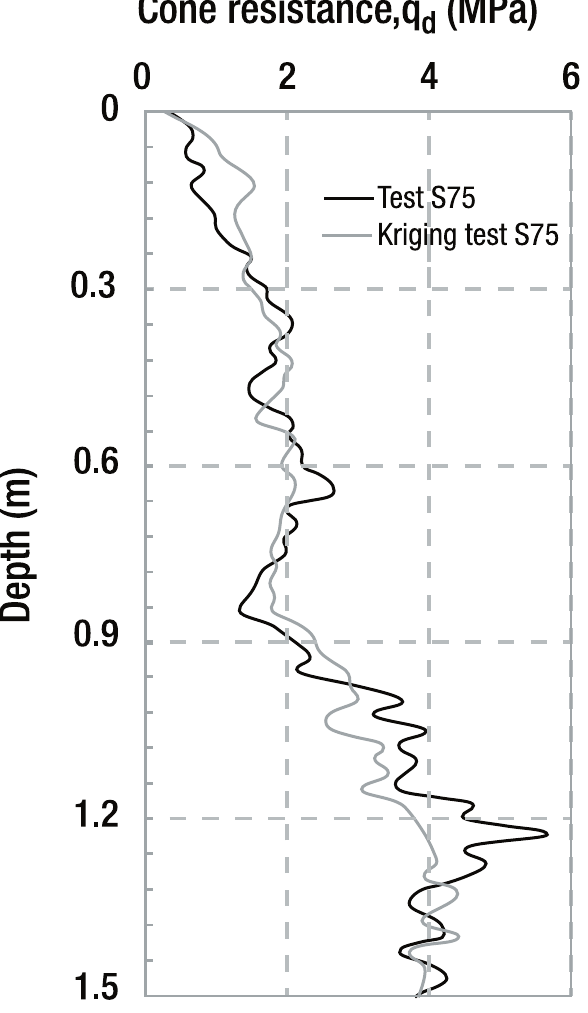
Figure 12. OK estimation of qd. yz-plane cross-sectional profile. PANDA test 75. Test slab